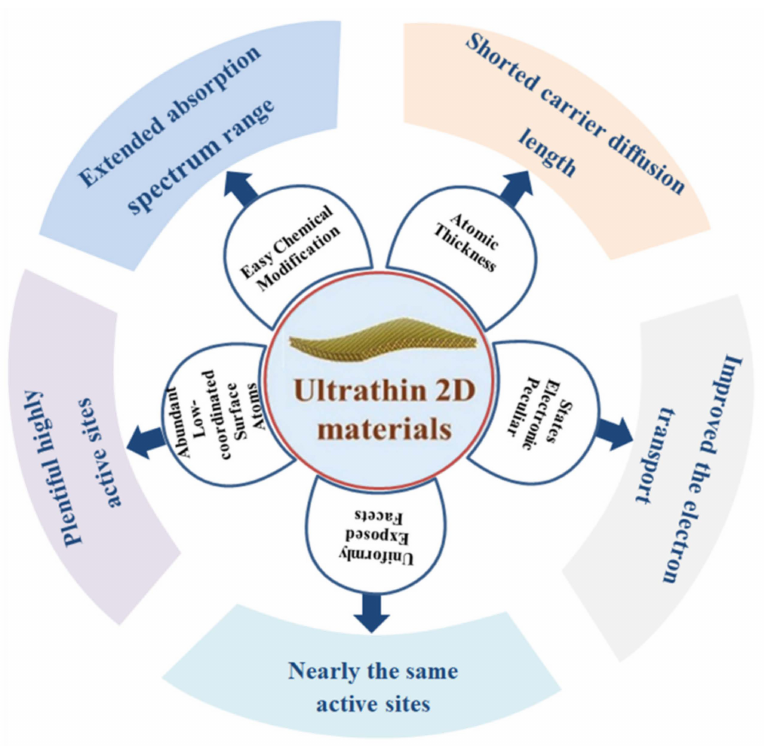
Figure 8. Diagram showing the benefits of ultrathin 2D materials. Reprinted with permission from Royal Society of Chemistry, 19 December 2021 Ref.